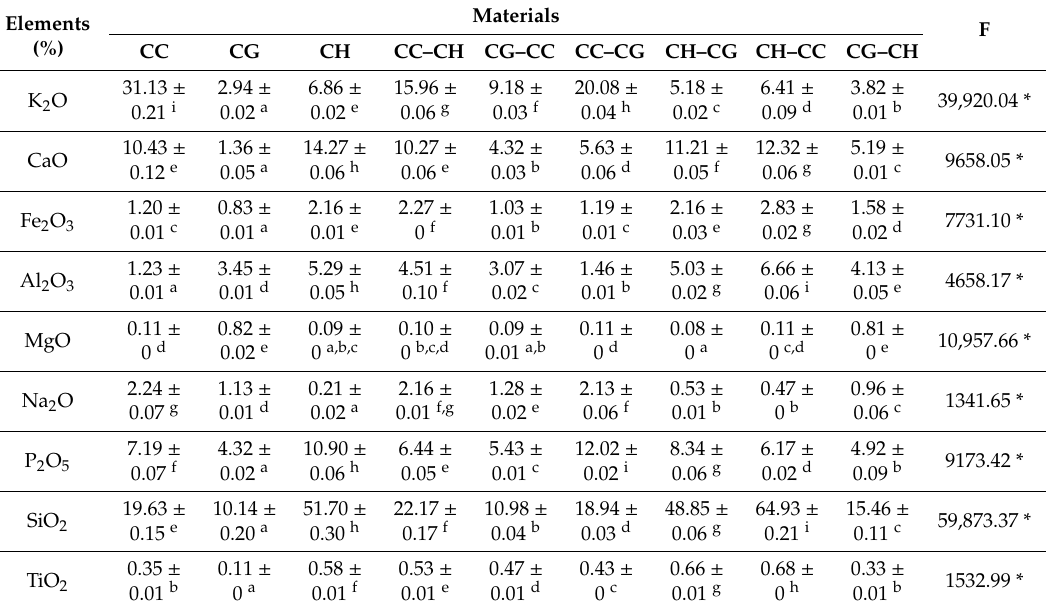
Table 3. Ash composition in the analyzed biomass (dry